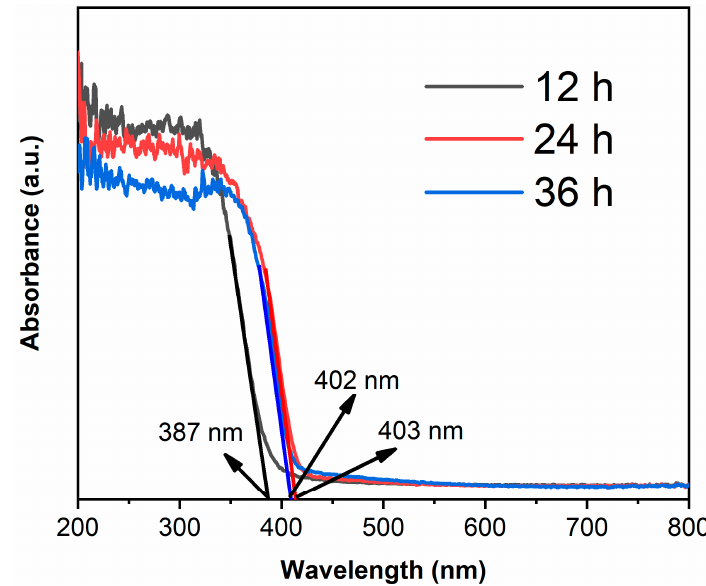
Figure 5. The UV-visible absorption spectra of TiO 2 -12 h, TiO 2 -24 h and TiO 2 -36 h.